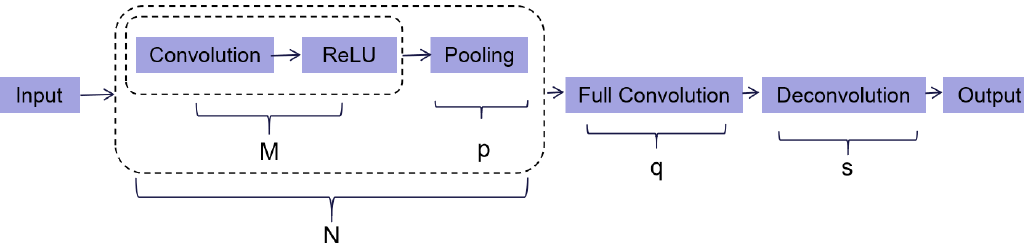
Figure 3. Typical architecture of FCN. A convolutional block contains a continuous M convolutional layers and p pooling layers. In a convolutional network, N continuous convolutional blocks can be stacked, followed by q fully convolutional layers and s deconvolutional layers.